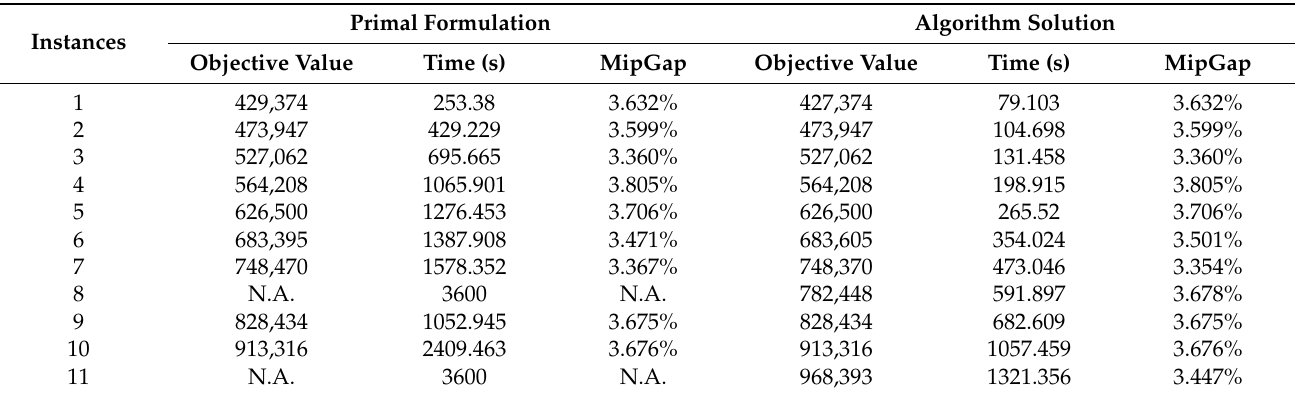
Table 4. Performance comparisons over large-scale instances. Maximum computational time was 3600